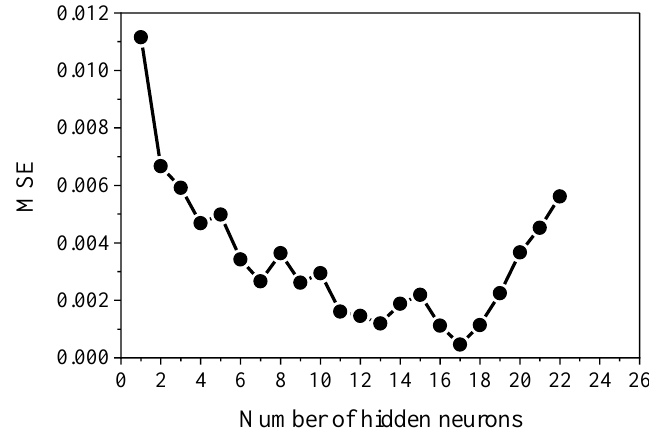
Figure 15. Variation of 𝑀𝑆𝐸 with the number of hidden neurons.